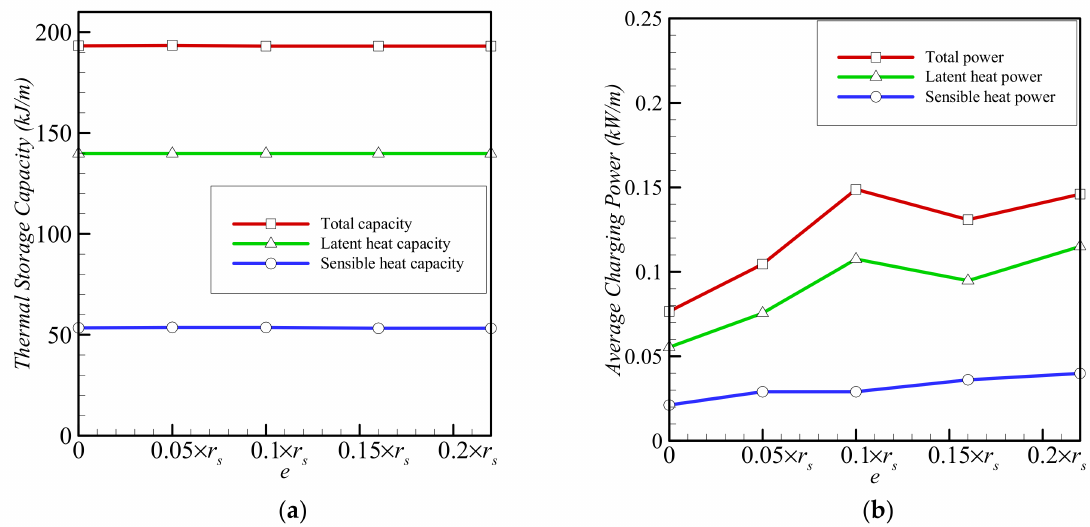
Figure 14. Variations of average thermal storage capacity ( a ) and average charging power ( b ) as functions of eccentricity e for copper nanoparticles for porosity ε = 0.8 and nanoparticle volume fraction σ =